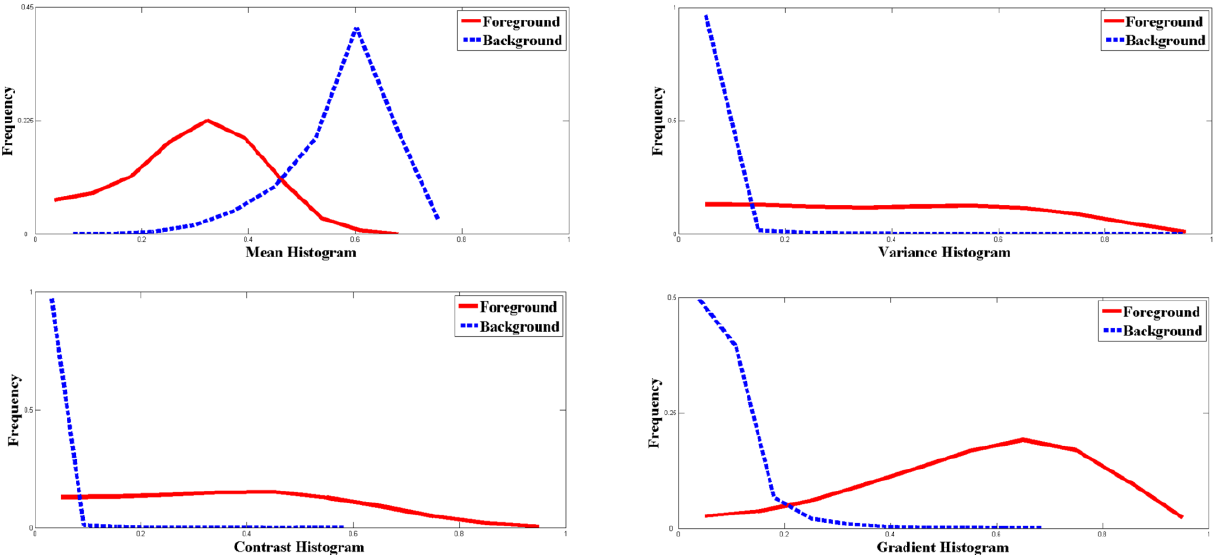
Figure 2. Features’ histograms of fingerprints in three different sub-databases of FVC2000.